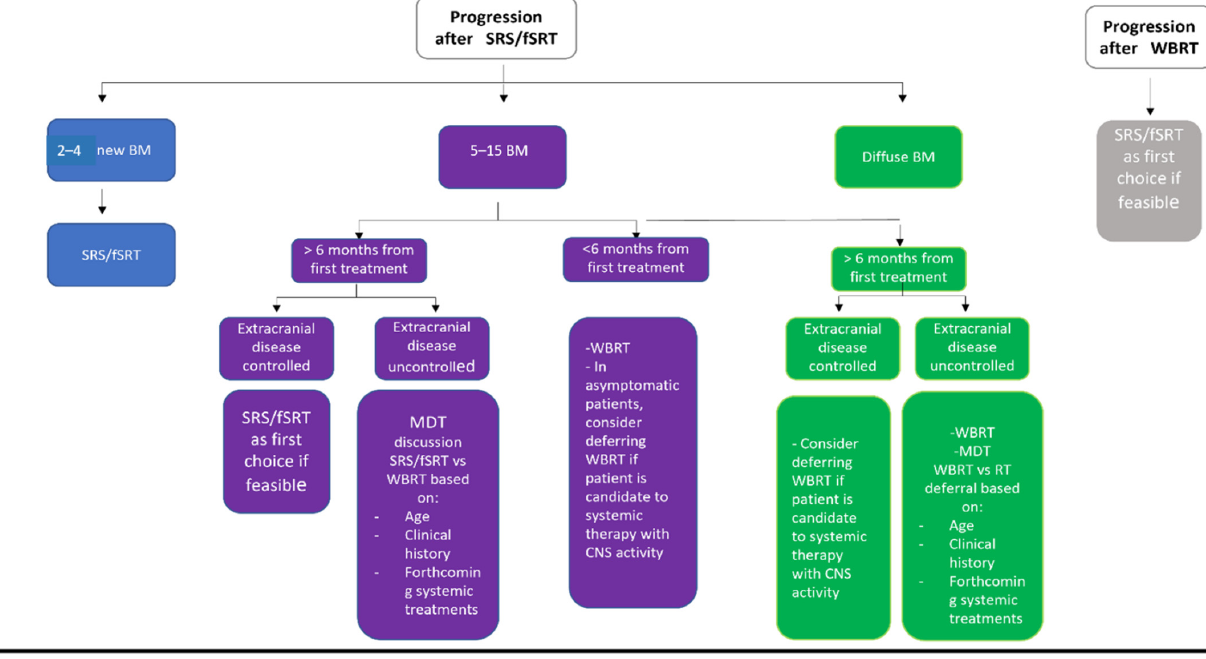
Figure 3. Proposed algorithm for recurrent HER2 BMs after brain RT.